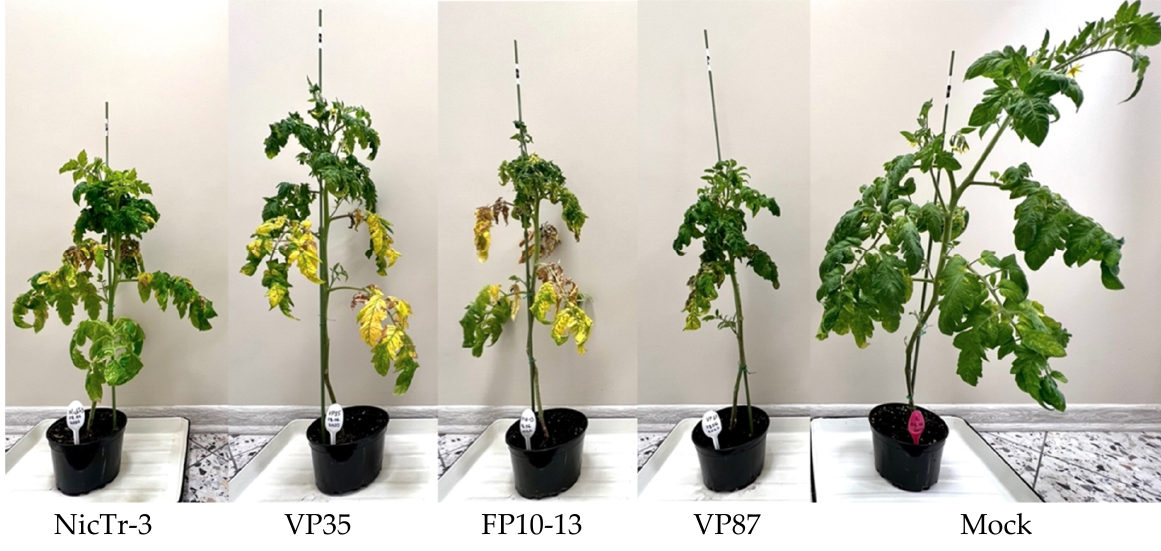
Figure 1. Symptoms in Rutgers tomatoes infected with four strains of PSTVd at 30 dpi. All PSTVd strains showed stunting, severe leaf curling, epinasty, stem and leaf necrosis; VP87 caused leaf mosaic and small necrosis (Figure